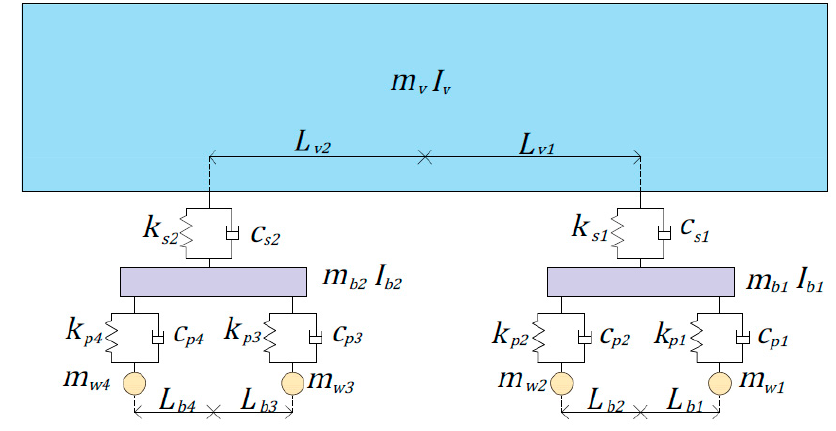
Figure 1. Two-dimensional (2D) 4-axle railway carriage model.